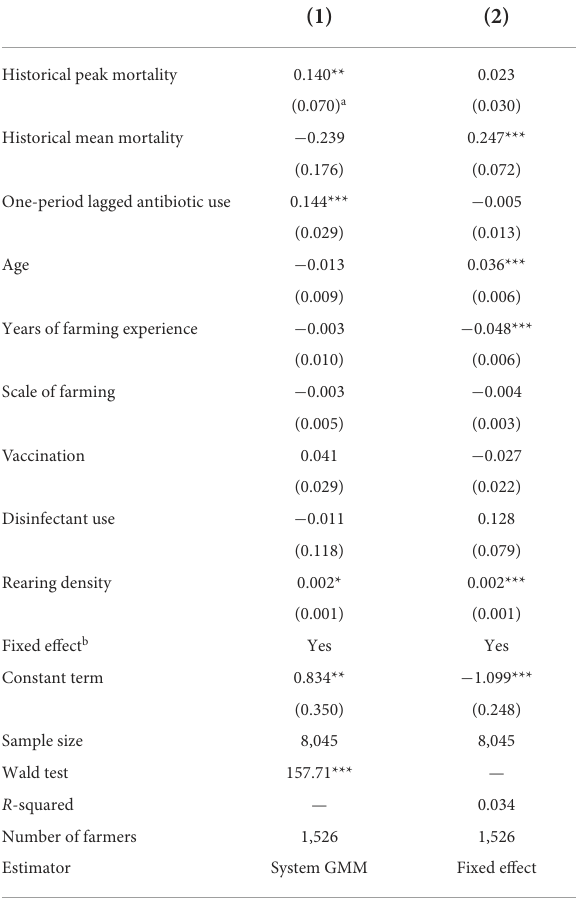
TABLE 2 The impact of historical peak mortality on current antibiotic